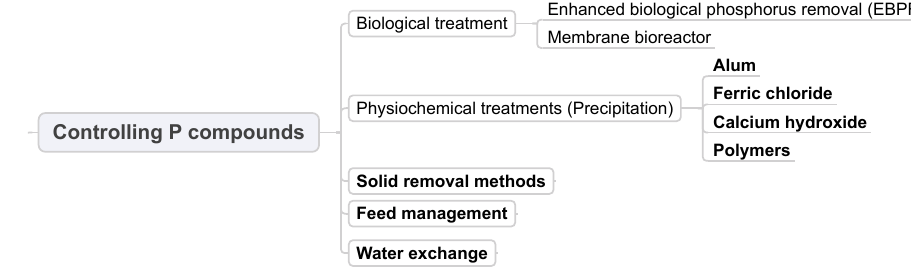
Figure 7. Taxonomy: controlling P compounds.